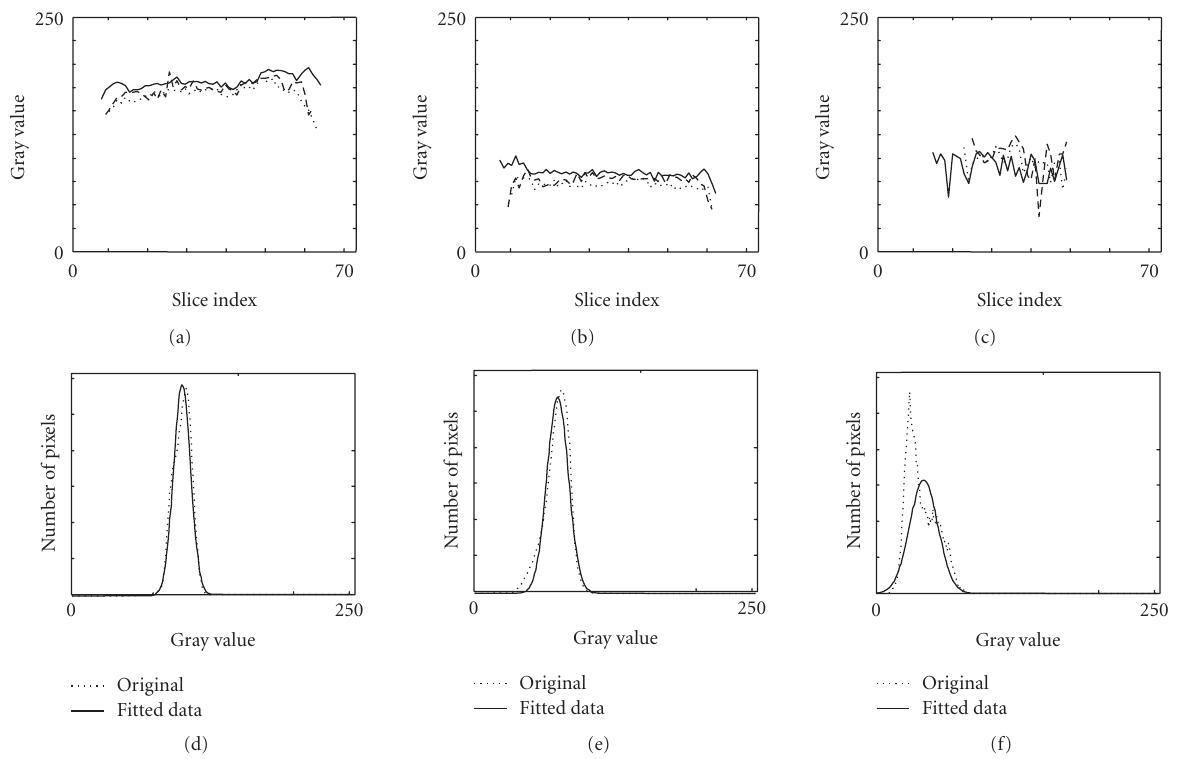
Figure 4: Intensity distributions and statistics for (a, d) WM, (b, e) GM, and (c, f) CSF. (a–c) Average values on consecutive slices within three MRI data sets represented with di ff erent line styles for the three MRI cases. (d–f) Fit of the volume histograms to Gaussian distributions for one MRI data set.